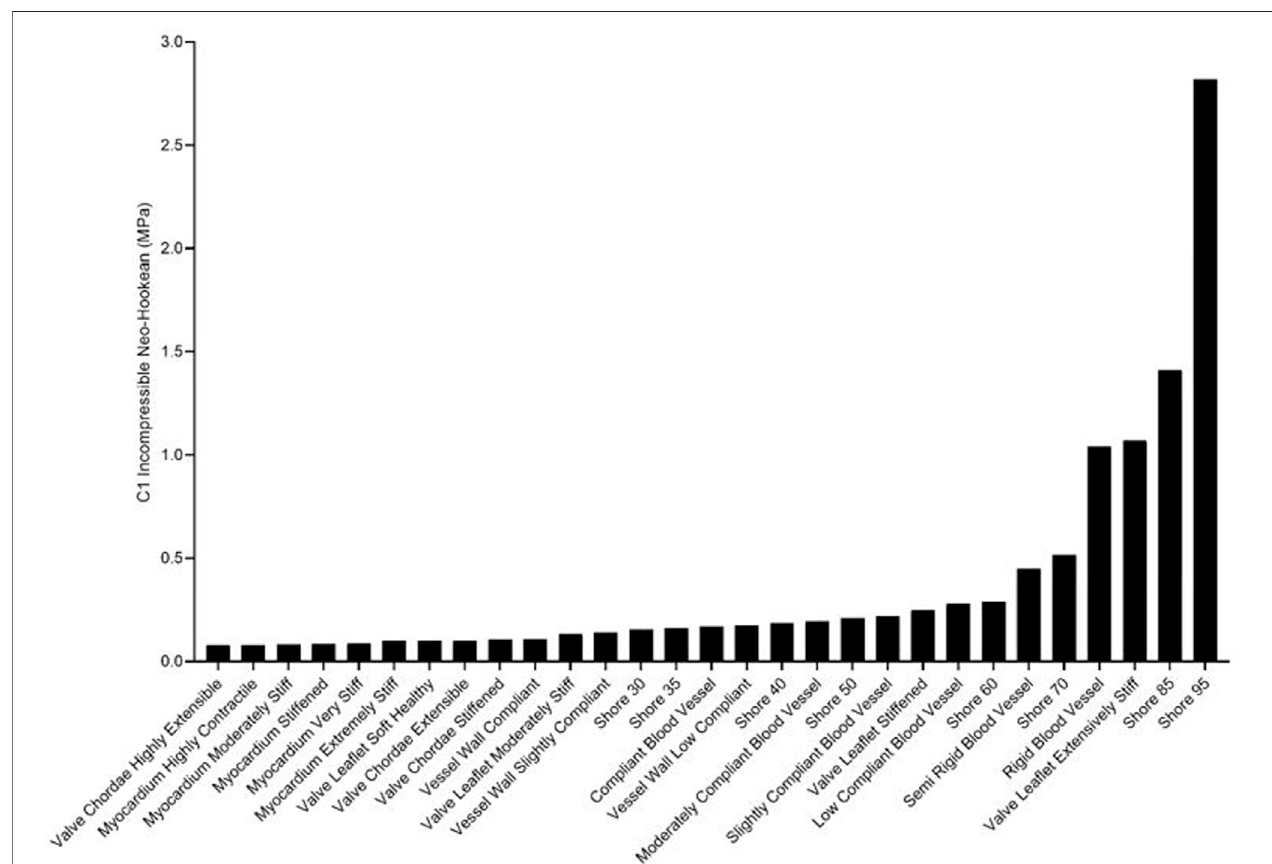
FIGURE5| Ranking ofJ750 3DprintedShore, theDAPblood vessel materials, and theDAPstructural heartmaterialsforthec1component oftheincompressible Neo-Hookean strain energy function of Eq. 6b .